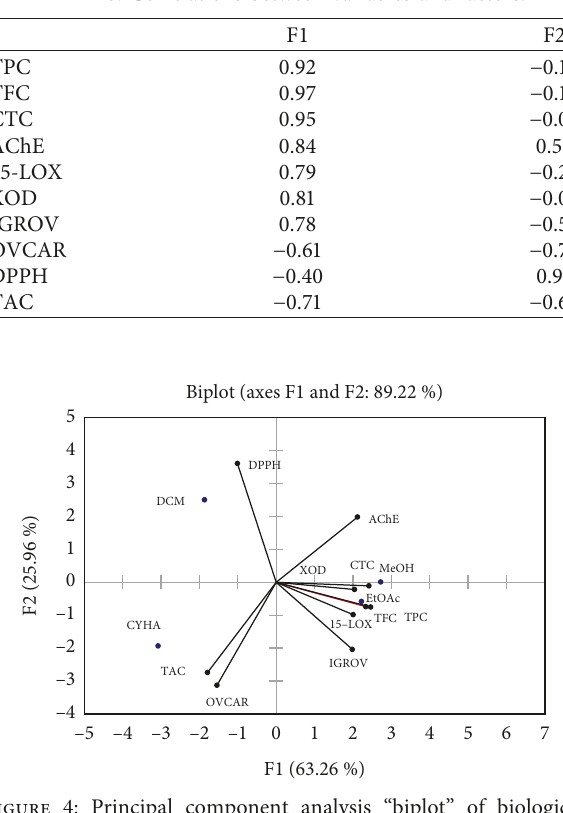
Figure 4: Principal component analysis “biplot” of biological activities M. mabokeensis Aubr´ev bark